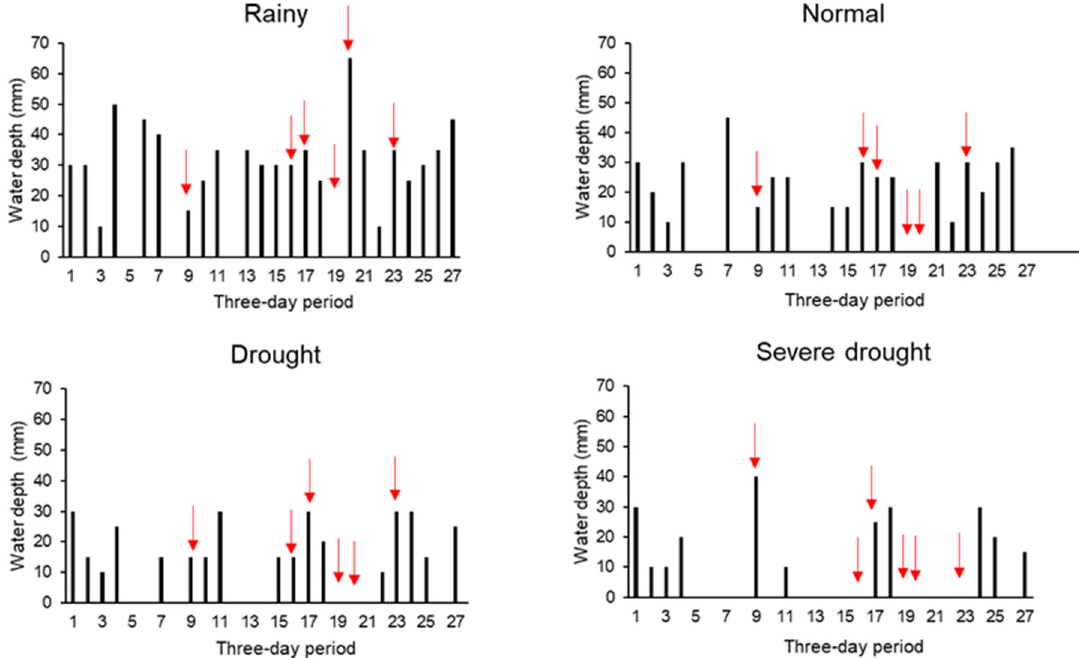
Figure 1. Water depths applied at three-day intervals in two maize crop cycles for different simulated water scenarios, without supplemental irrigation. The red arrows indicate the moments of leaf gas exchange measurements.